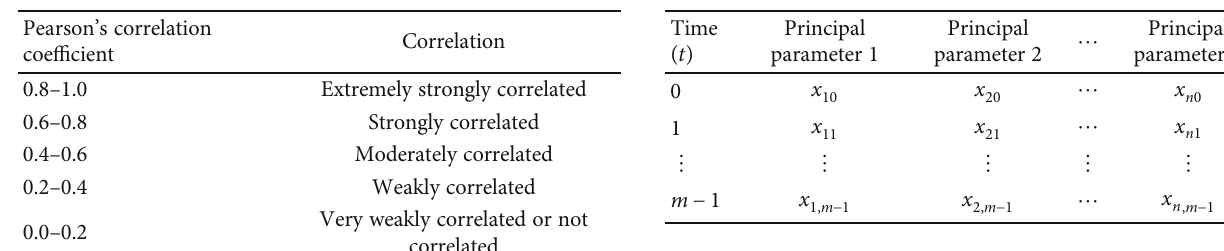
Table 1: Correlation degree. Table 2: Hypothetical